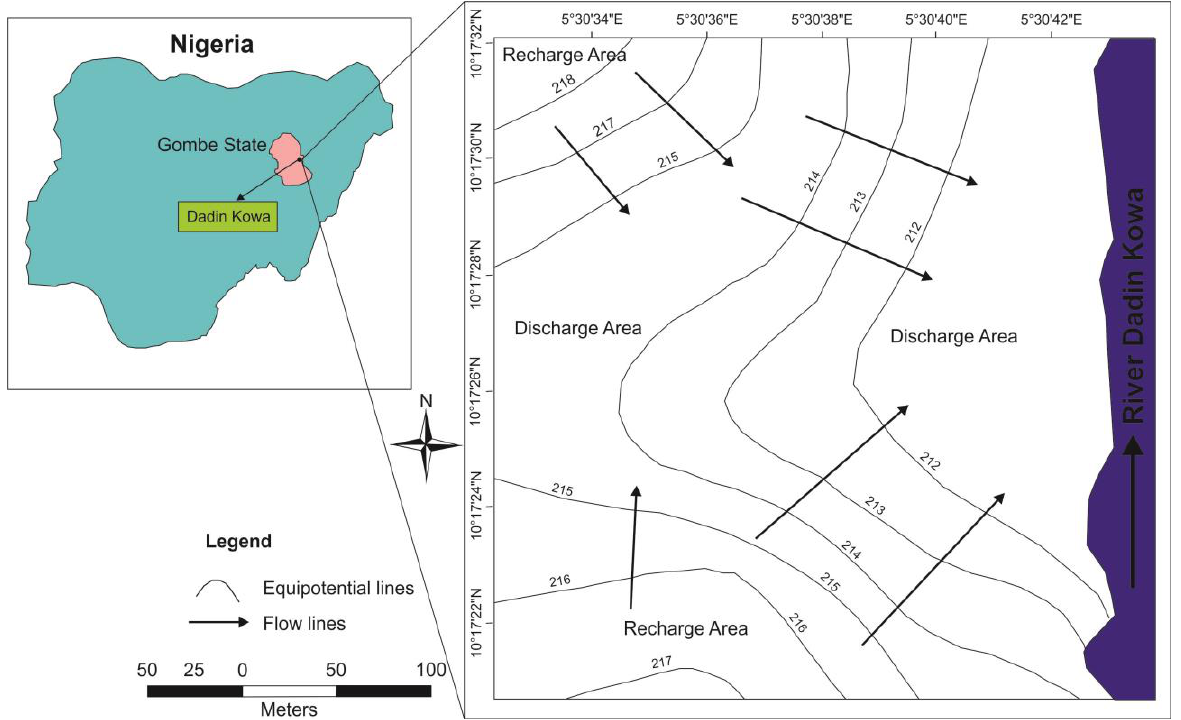
Fig. 9. Hydraulic heads distribution across the